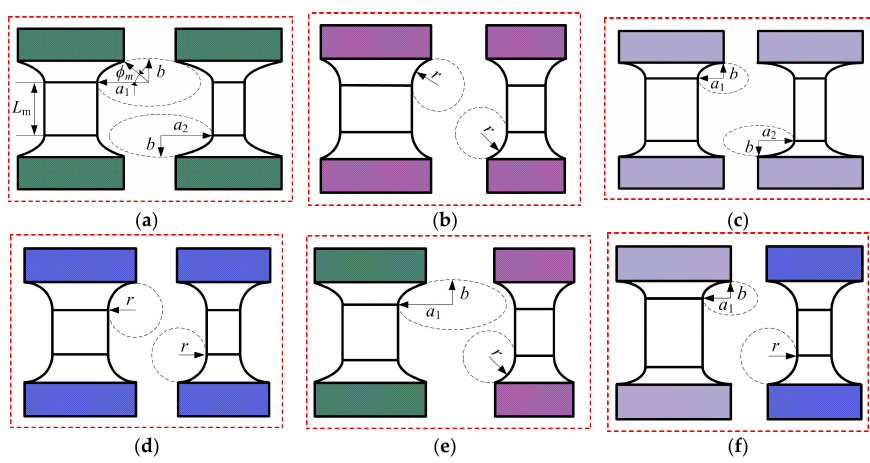
Figure 2. Geometric parameters and profiles of two-axis corner-filleted flexure hinge.